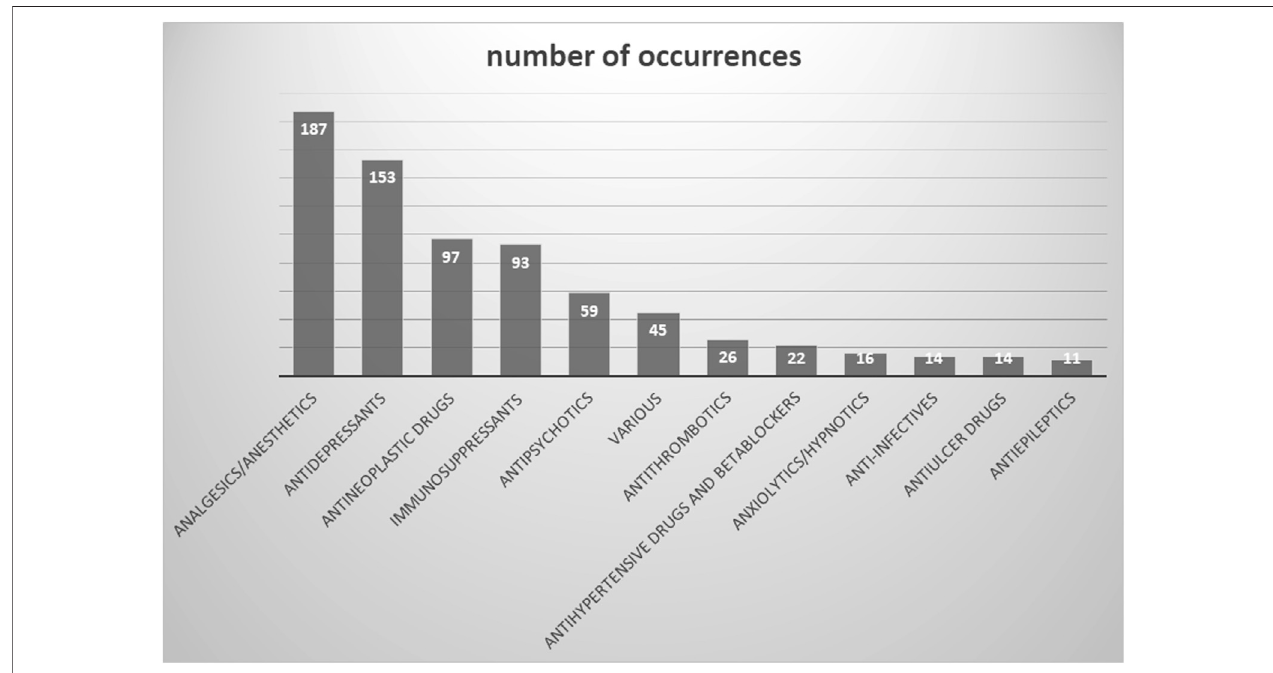
FIGURE 3 | Involved therapeutic classes.